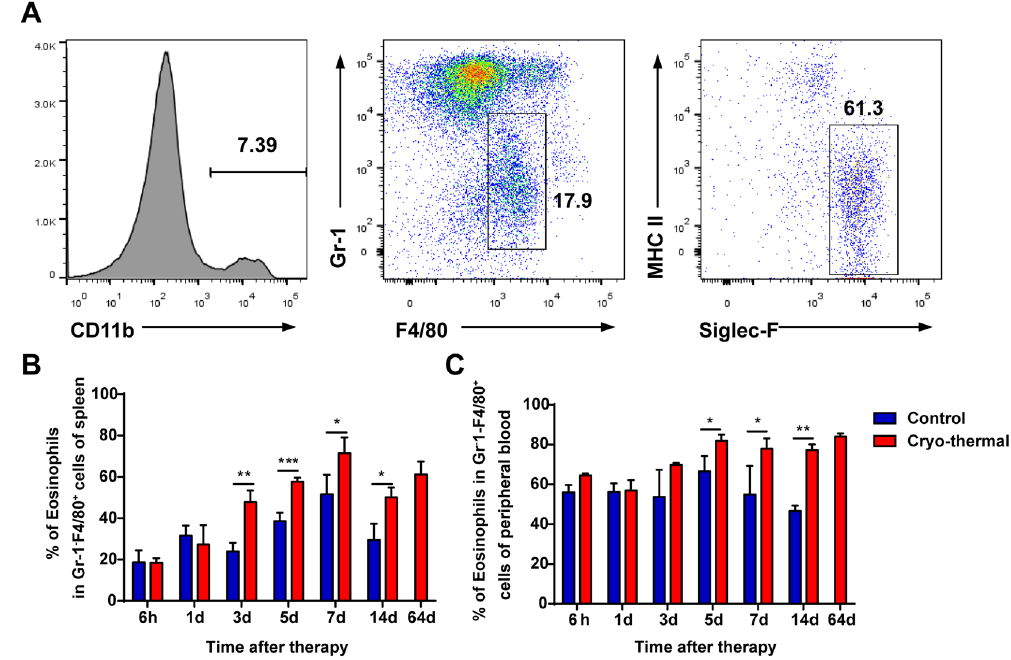
Figure 1. Cryo-thermal therapy induced increase of the proportion of eosinophils in spleen and peripheral blood. The phenotype of immune cells harvested from the spleen and peripheral blood in cryo-thermal- treated mice and tumour-bearing mice was analyzed by flow cytometry. ( A ) Flow cytometry gating strategy for determination of eosinophils in spleen and peripheral blood. Flow-cytometry analysis of the dynamic change of eosinophils (CD11b + Gr-1 − F4/80 + MHC II − Siglec-F + ) in spleen ( B ) and peripheral blood ( C ) was performed at different time points (6 h, 1d, 3d, 5d, 7d, 14d and 64d after the cryo-thermal therapy), as compared to the tumour-bearing control group. n = 4 mice at each time point per group. Data was shown as mean ± SD. Data for bar graphs was calculated using student’s t-test. * p < 0.05; ** p < 0.01; *** p <